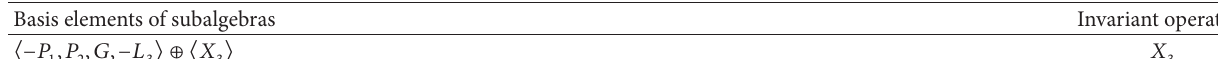
Table 16: Invariant operator of subalgebra of the type 𝐴 4,12 ⊕ 𝐴 1